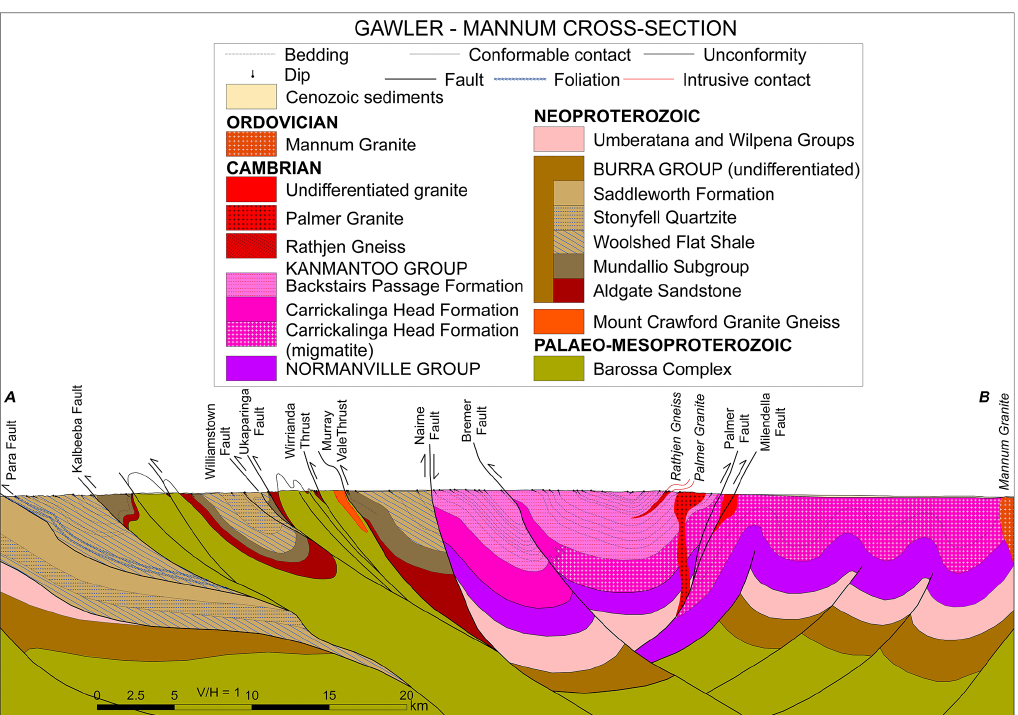
Figure 3. Interpretative cross section across the southern Delamerian Orogen from Gawler to Mannum. Both the topographic profile and surface geology, including the dip of structural elements, are well constrained from previous mapping, but their extrapolation at depth in this diagram is more speculative. The left-hand portion of the cross section illustrates the westerly vergence of the major structures in the western low-grade metamorphic zones and the involvement of the basement. Many of the faults originated as extensional faults in the basement as a result of Neoproterozoic and Cambrian rifting. Of the mapped major faults, the Para, Kalbeeba, Williamstown, Bremer, Palmer, and Milendella faults all display compressional neotectonic reactivation. The Nairne Fault differs from other faults in being a ?late Delamerian normal reactivation of a Cambrian extensional fault and locally forms the western boundary of the Kanmantoo Trough. The metamorphic grade jumps from greenschist facies to sillimanite grade across the Williamstown Fault, while migmatite is widely developed in the oldest formation of the Kanmantoo Group. Geology beneath the Kanmantoo Group is schematic only. The location of the cross section is shown